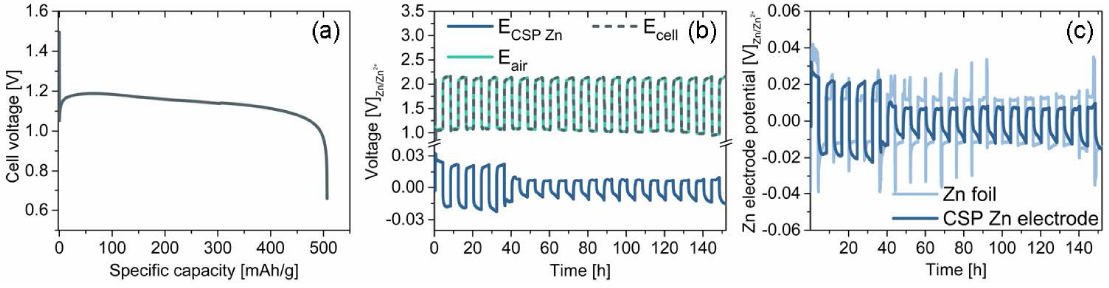
Figure 7. Results of the electrochemical characterization tests, showing ( a ) voltage of a ZAB cell galvanostatically discharged to a cutoff voltage of 0.65 V, ( b ) cell voltage and electrode potentials for a ZAB over 152 h, and ( c ) potential of the cold-sintered Zn electrode compared with the potential a Zn foil electrode cycled under the same